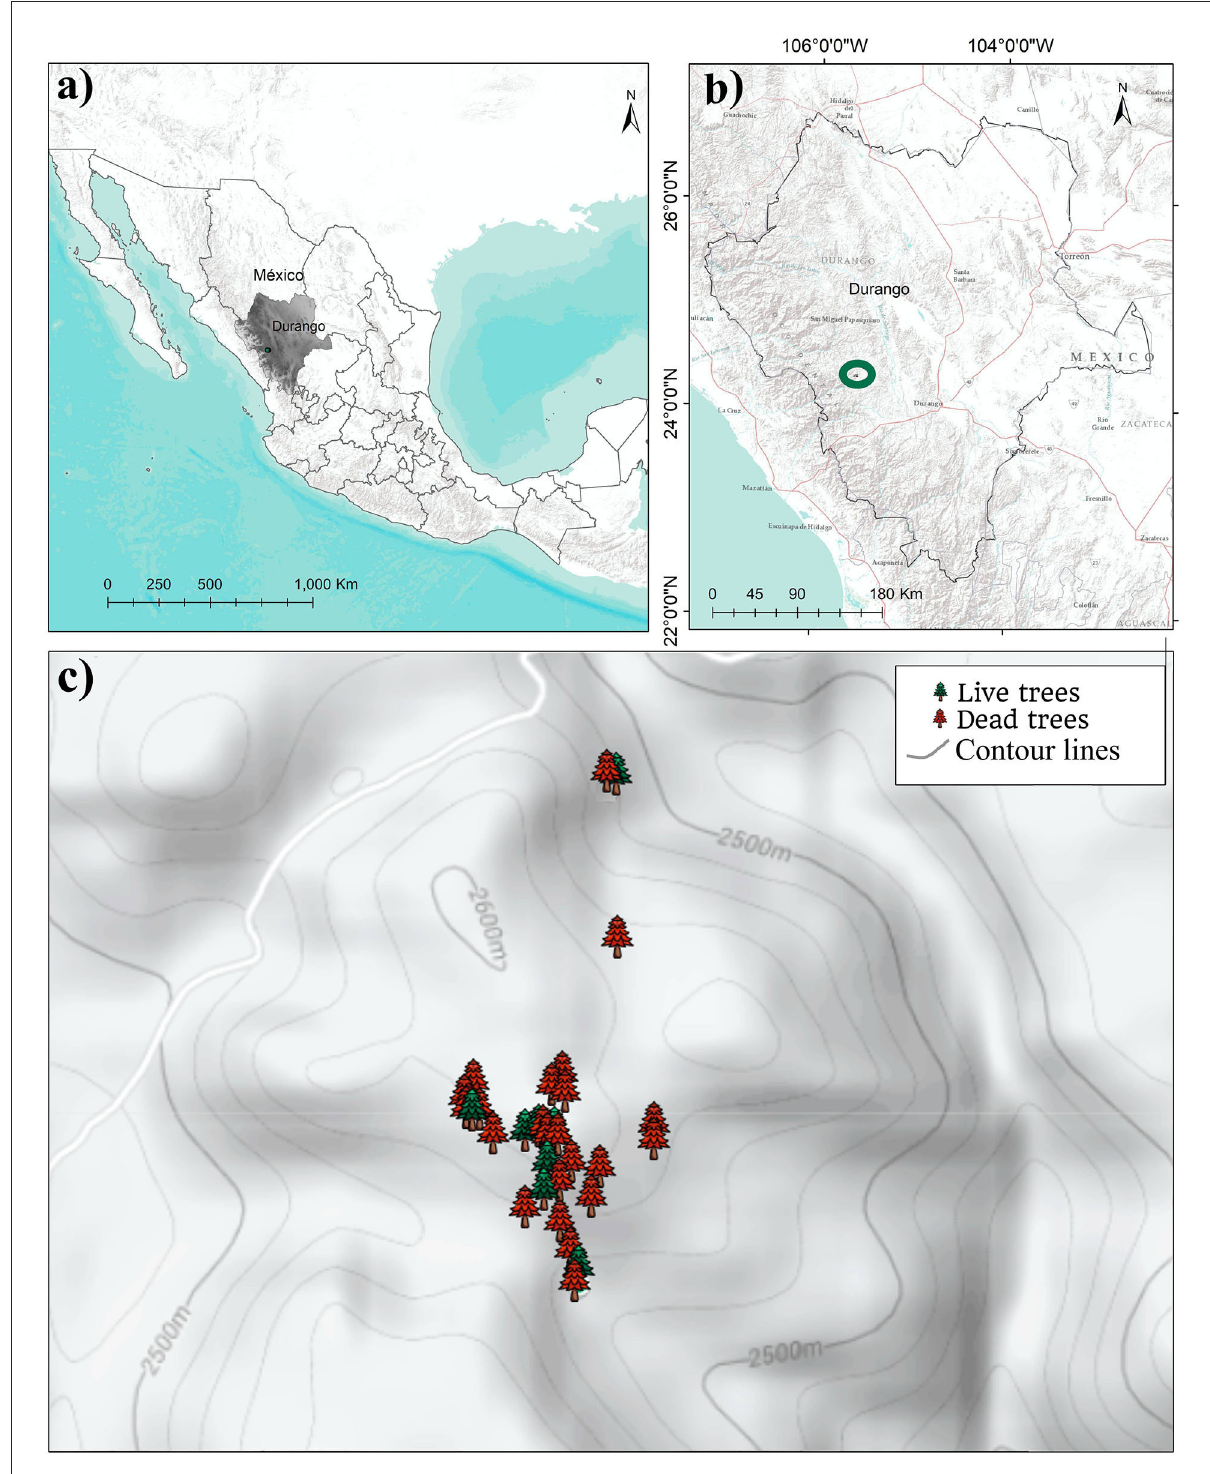
FIGURE1 Study site location in the northern Mexico (A) and within the state of Durango (B) . Location on 40 fire scarred trees collected within the 50-ha study site at Río de Miravalles (C)